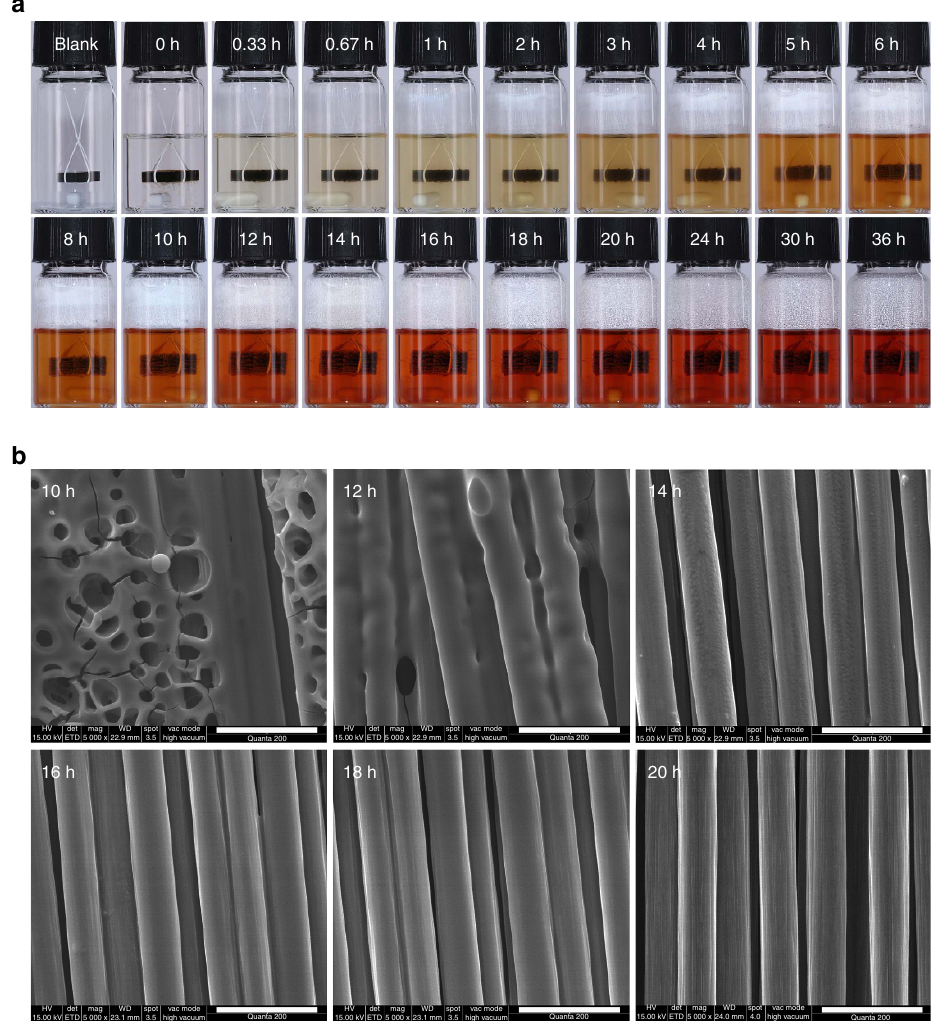
Figure 4 | Degradation of the cross-ply CF/PHTcomposite laminates at room temperature. ( a ) The degradation process in 10ml 1M HCl/THF solution at different times; ( b ) SEM images of the recycled CFs at different depolymerization times. Scale bar, 20 m